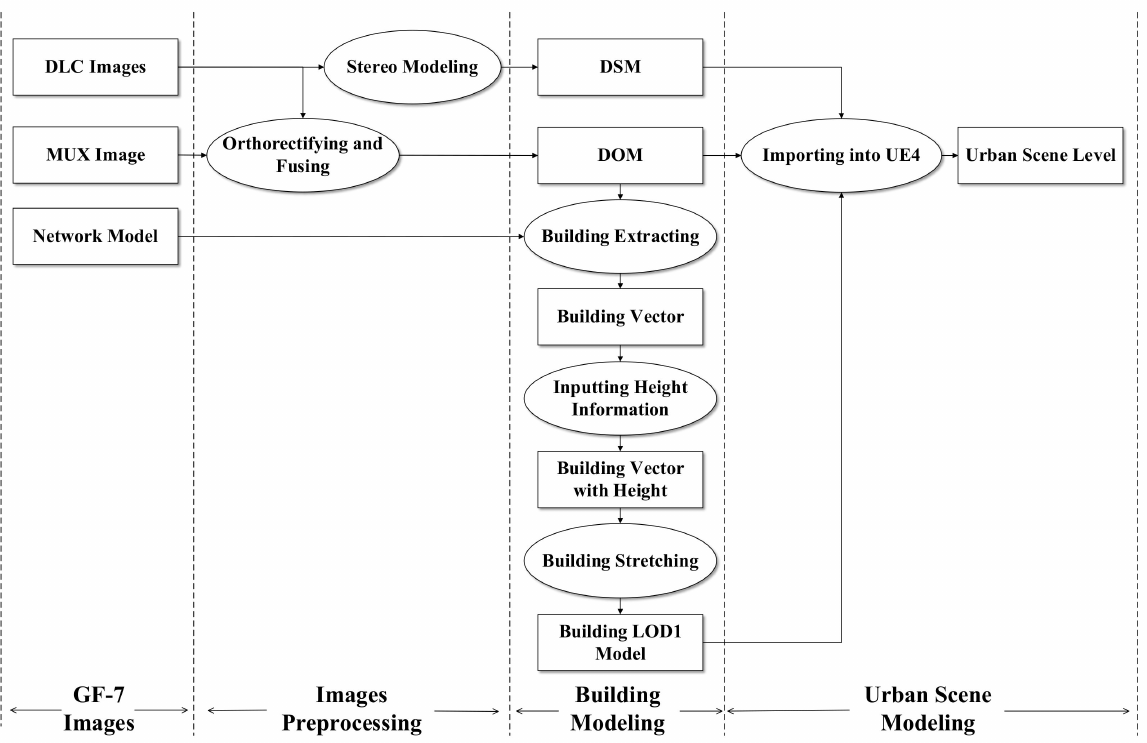
Figure 1. Workflow of urban scene